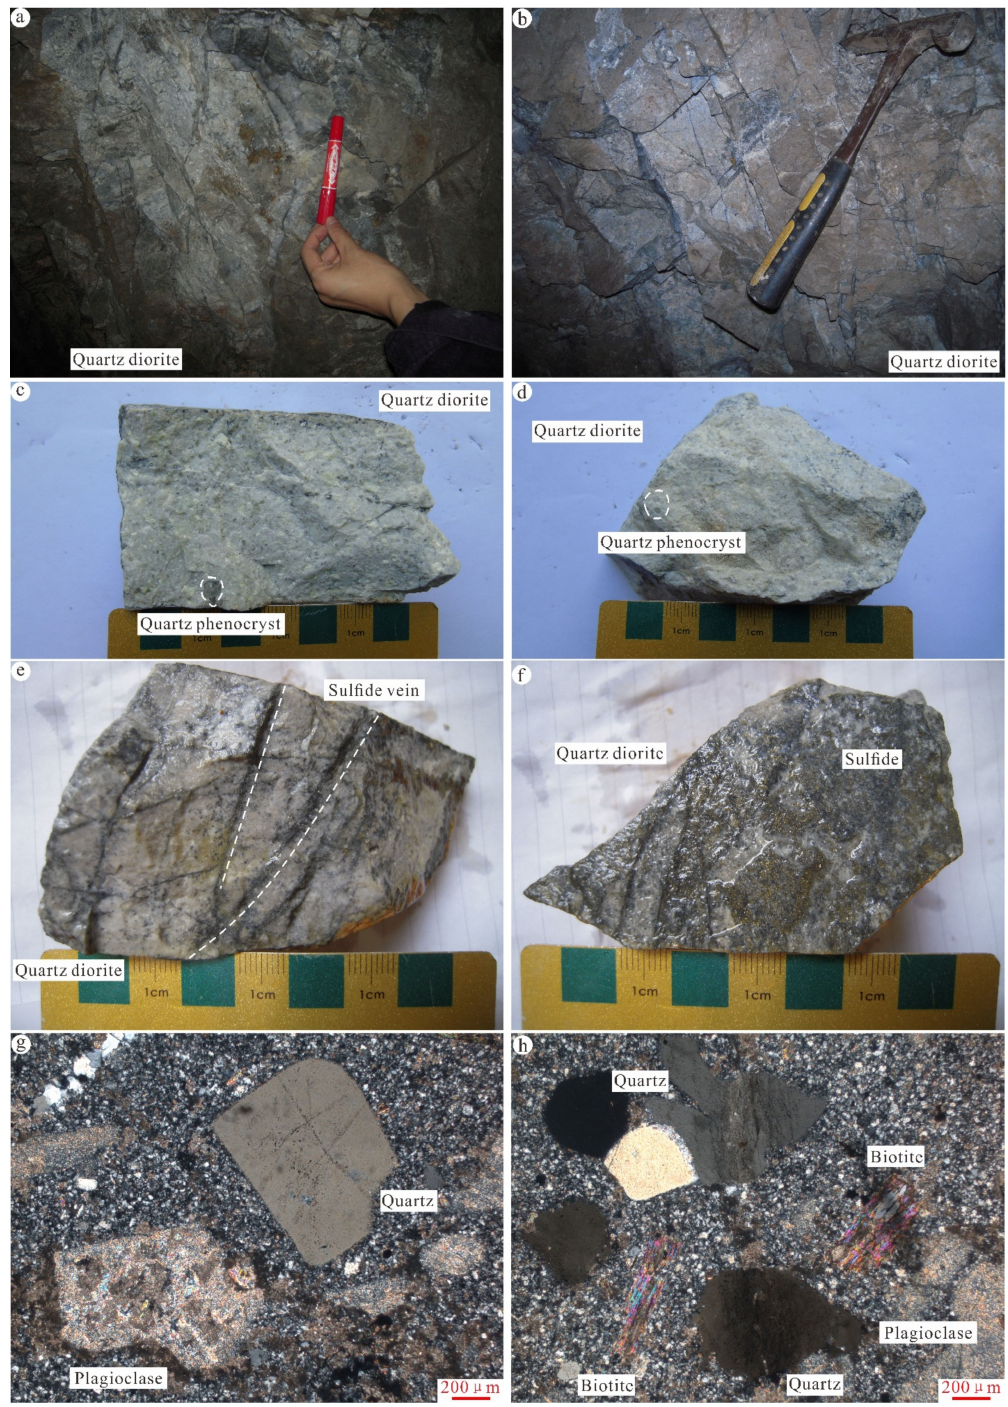
Figure 4. The quartz diorite pluton and mineral features of the quartz diorite at Yangla. ( a ): Quartz diorite exposed by stop 41 # -1 in the 3250 m sections of the Linong ore block. ( b ): quartz diorite exposed at stop 41 # -1 in the 3250 m sections of the Linong, showing a large number of joints and fissures within the pluton, together with quartz veins. ( c ): Light-gray to grayish-white massive quartz diorite; the plagioclase phenocrysts have been altered to present grayish-white corrosion, and quartz phenocrysts are subhedral granular (Sample No. 41-1). ( d ): Light-gray to grayish-white massive quartz diorite, showing the